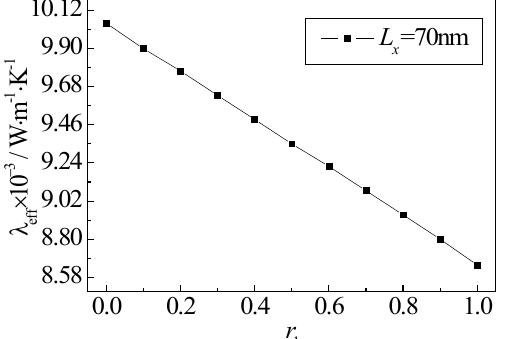
Fig. 5. Effective thermal conductivity of r b .